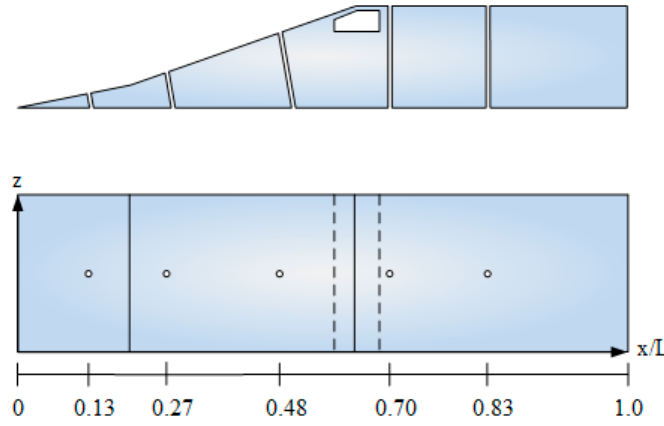
Figure 11. Pressure tapings located along the length of the intake-core.